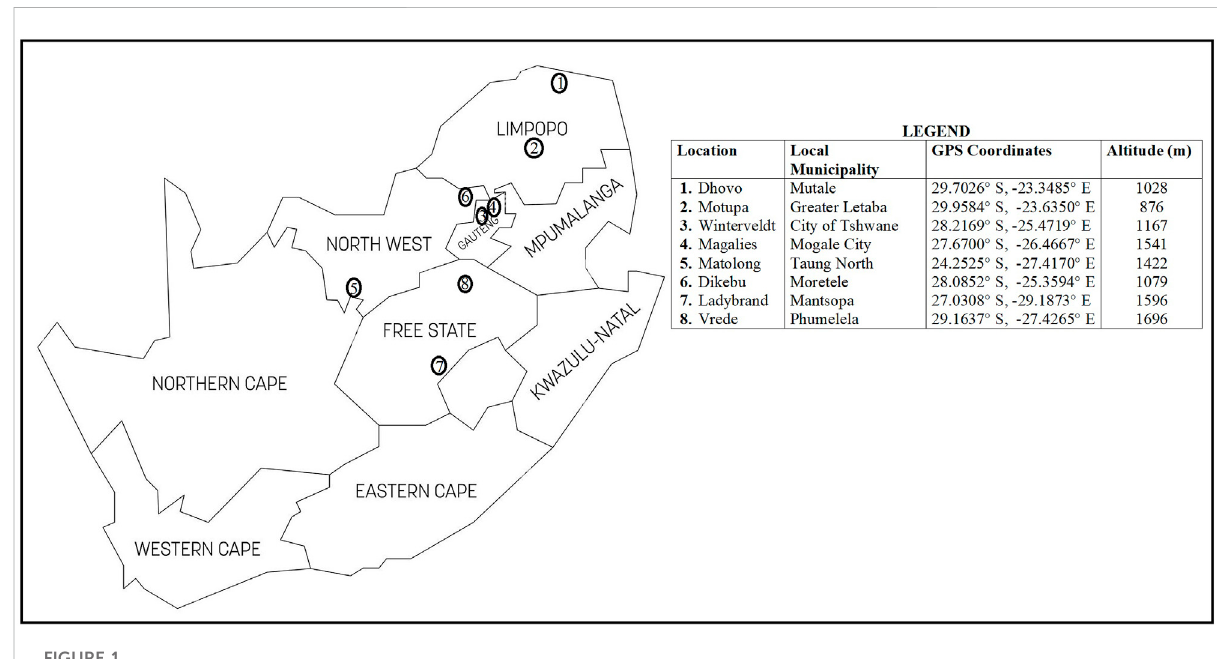
FIGURE 1 South African map showing the geographical locations of communal indigenous goat